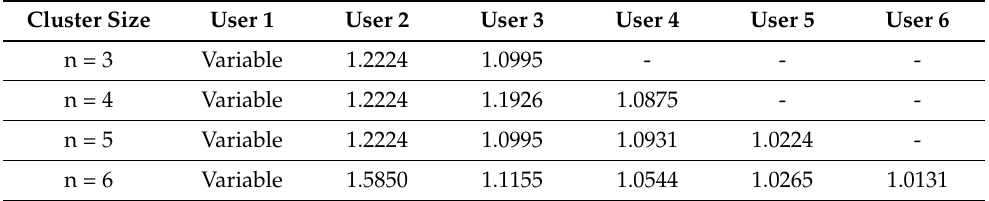
Table 5. Normalized IDRs’ theoretical upper bound in bits per sec per Hertz for different cluster sizes in Downlink RIS-NOMA, when magic matrix-based power allocation [22] is adopted.